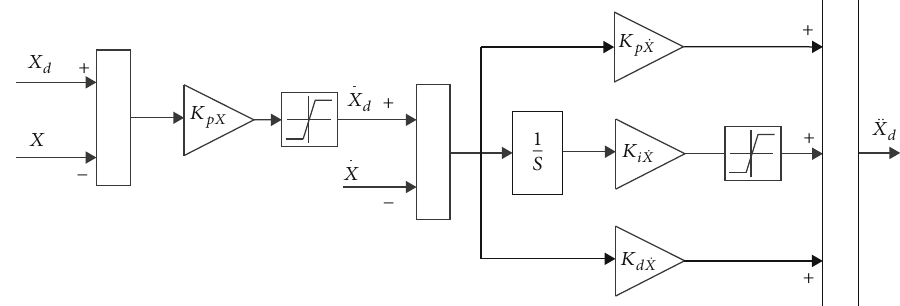
Figure 15: Position and attitude controller structure of the Quad-Plane, where X denotes the position or attitude.